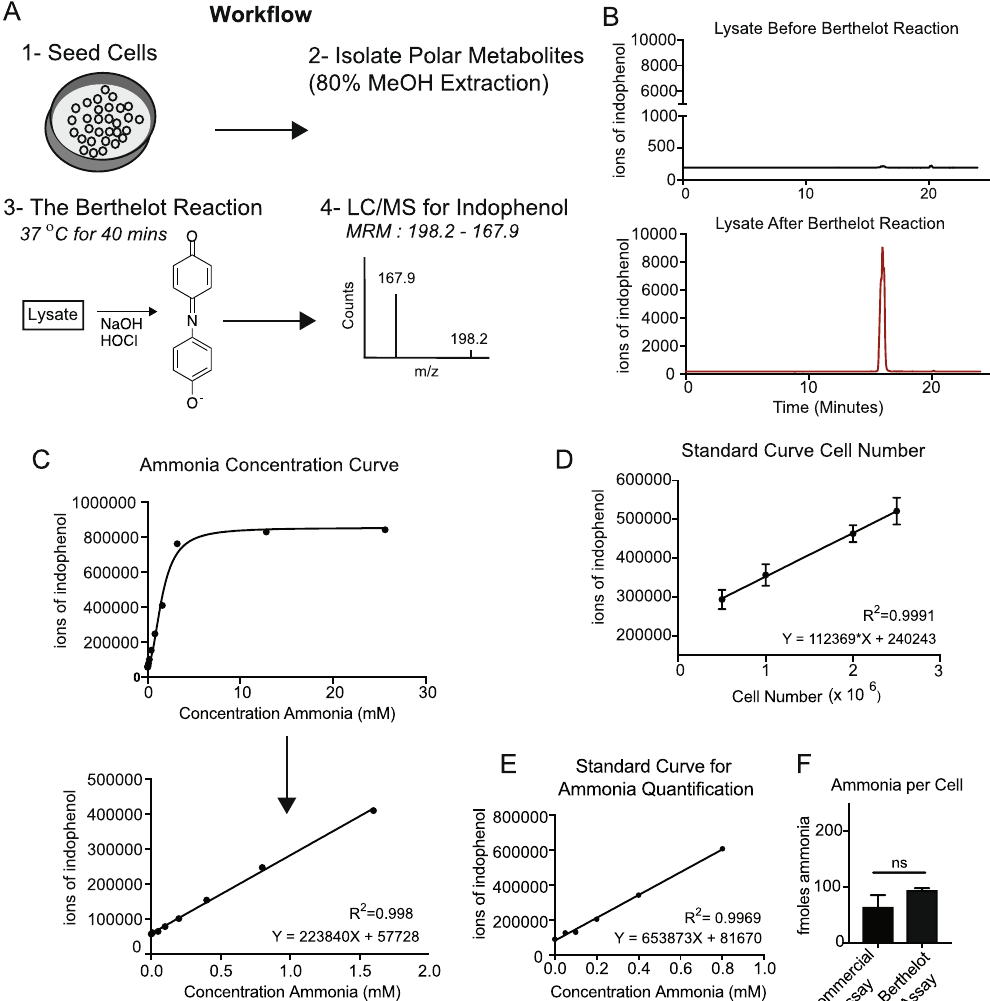
Figure 3. Assay development in cellular lysates. ( A ) Schematic of the work flow for measuring ammonia from a cellular lysate. ( B ) Total ion chromatogram for the MRM transition of 198.2: 167.9 in a cellular lysate extracted with 80:20 methanol:water (top) and a cellular lysate after the Berthelot reaction (bottom). ( C ) Concentration curve of the Berthelot reaction on samples with increasing ammonia spiked into cellular lysate from 3 × 10 6 293T cells. ( D ) Standard curve of the Berthelot reaction performed on cellular lysates from increasing cell number. ( E ) Standard curve of the Berthelot reaction performed on cellular lysates with spiked in concentrations of ammonia. ( F ) Measurement of moles of ammonia per cell using the standard addition technique with the Indophenol assay, and in parallel from the same lysate, measurement of ammonia using a standard assay (n = 3